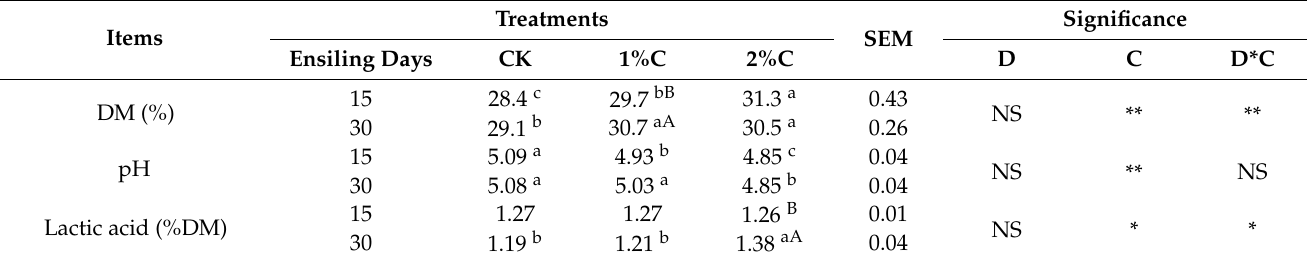
Table 2. Effect of mixing biochar on fermentation parameters and microbial populations of alfalfa ensiled for 15 and 30 d.